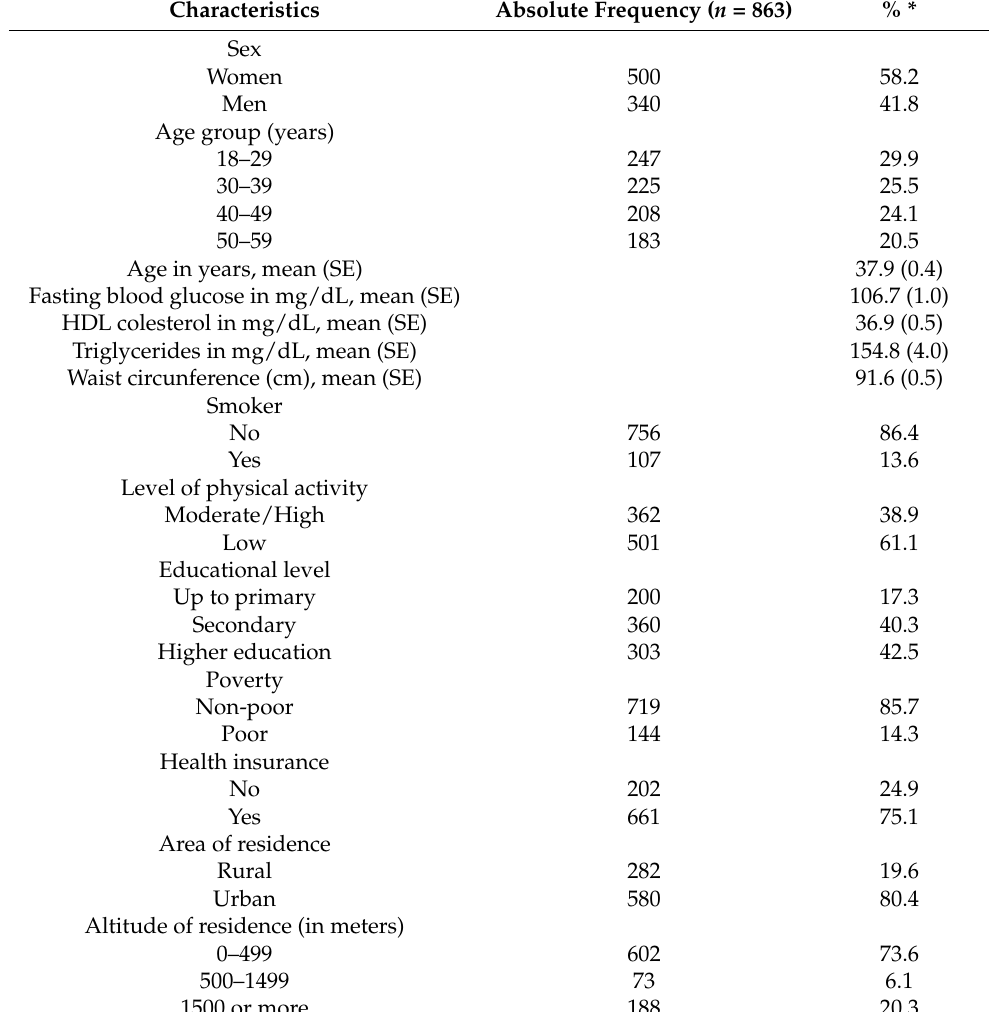
Table 1. Characteristics of the participants included in the